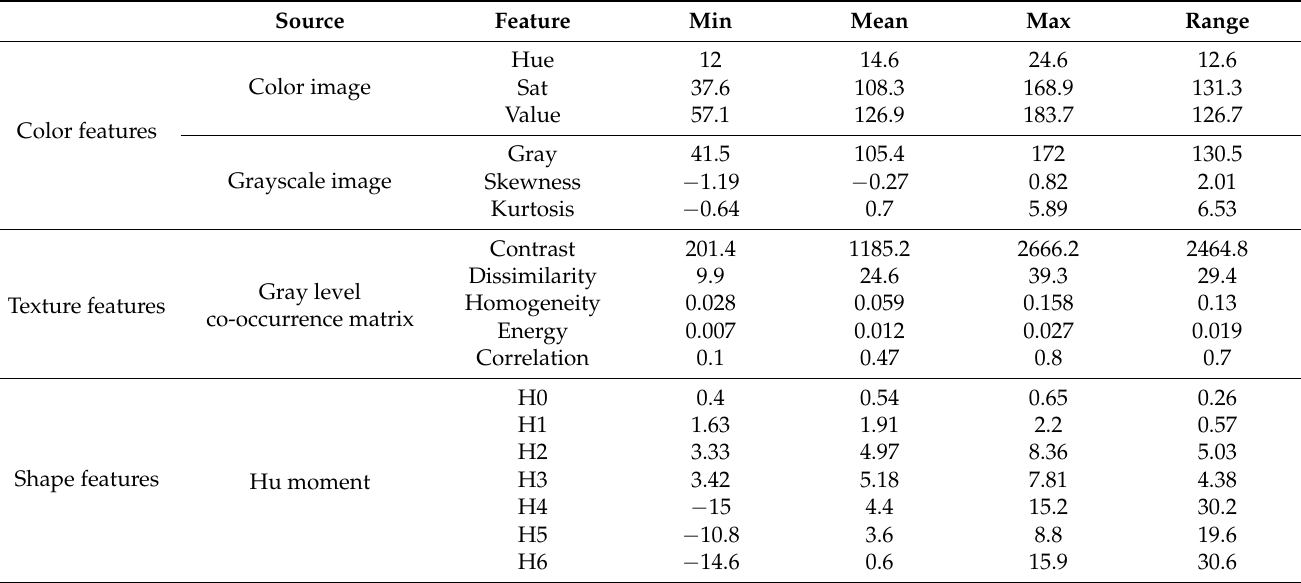
Table 3. Extracted features from soil surface images for deep neural network and multiple regression analysis.